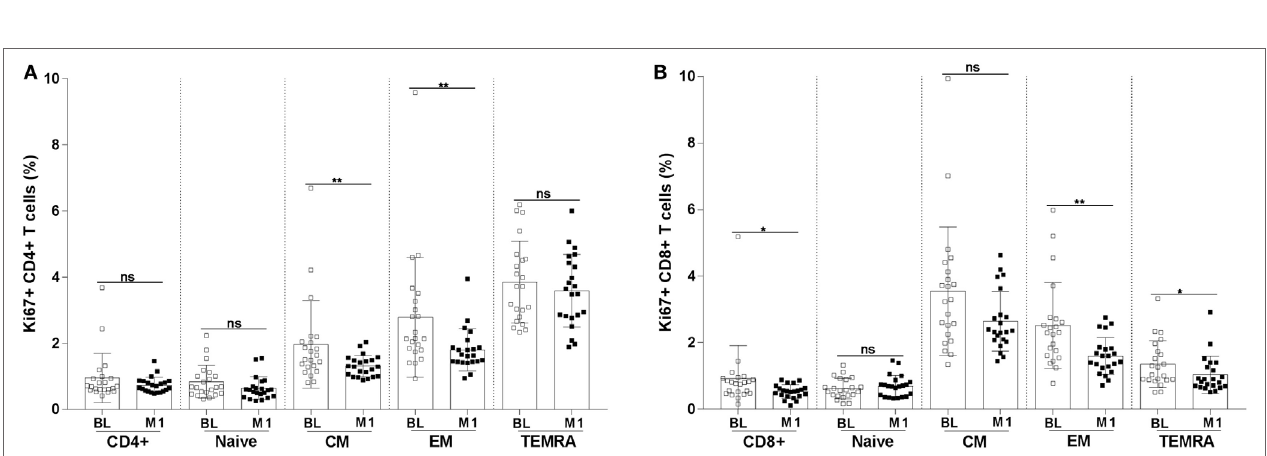
FigUre 4 | Frequency of Ki67 + CD4 + and CD8 + T-cell subpopulations. The frequency of Ki67 + CD4 + (a) and CD8 + (B) T-cell subpopulations (naïve, CM, EM, and TEMRA) were measured in blood specimens of 22 HIV-1-infected children at baseline and 1 month postvaccination. * p < 0.05; ** p < 0.01; ns, not significant; BL, baseline; M1, month 1.